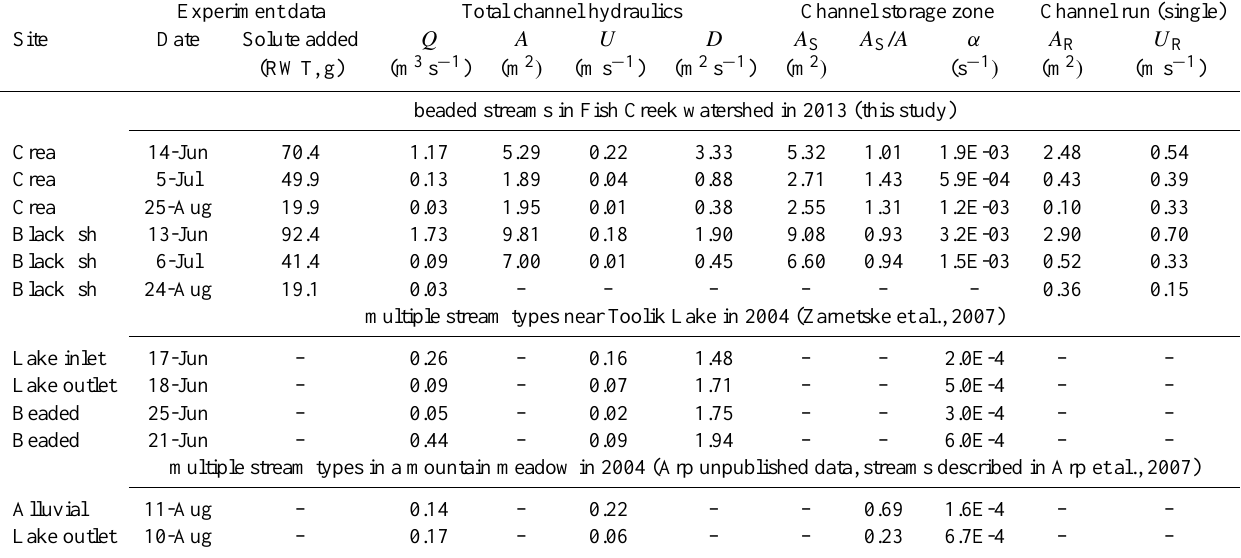
Table 3. Results from reach-scale tracer injections for Crea (325m, shallow elliptical beads) and Blackfish (232m, deep coalesced beads) creeks during the summer of 2013 (RWT is rhodamine WT, Q is stream discharge, A is the advective cross-sectional area, U is advective zone velocity, D is the dispersion coefficient, A S is the storage zone cross-sectional area, A S / A is the relative storage zone area, α is the storage zone exchange coefficient, A R and U R are the cross-sectional area and velocity, respectively, of a single channel run). Comparisons of these results are made to two other RWT tracer studies of similar sized streams with beaded and other channel